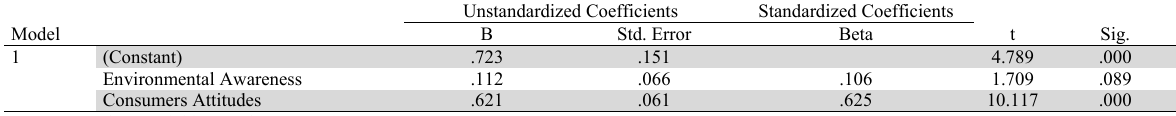
Multiple Regression Analysis